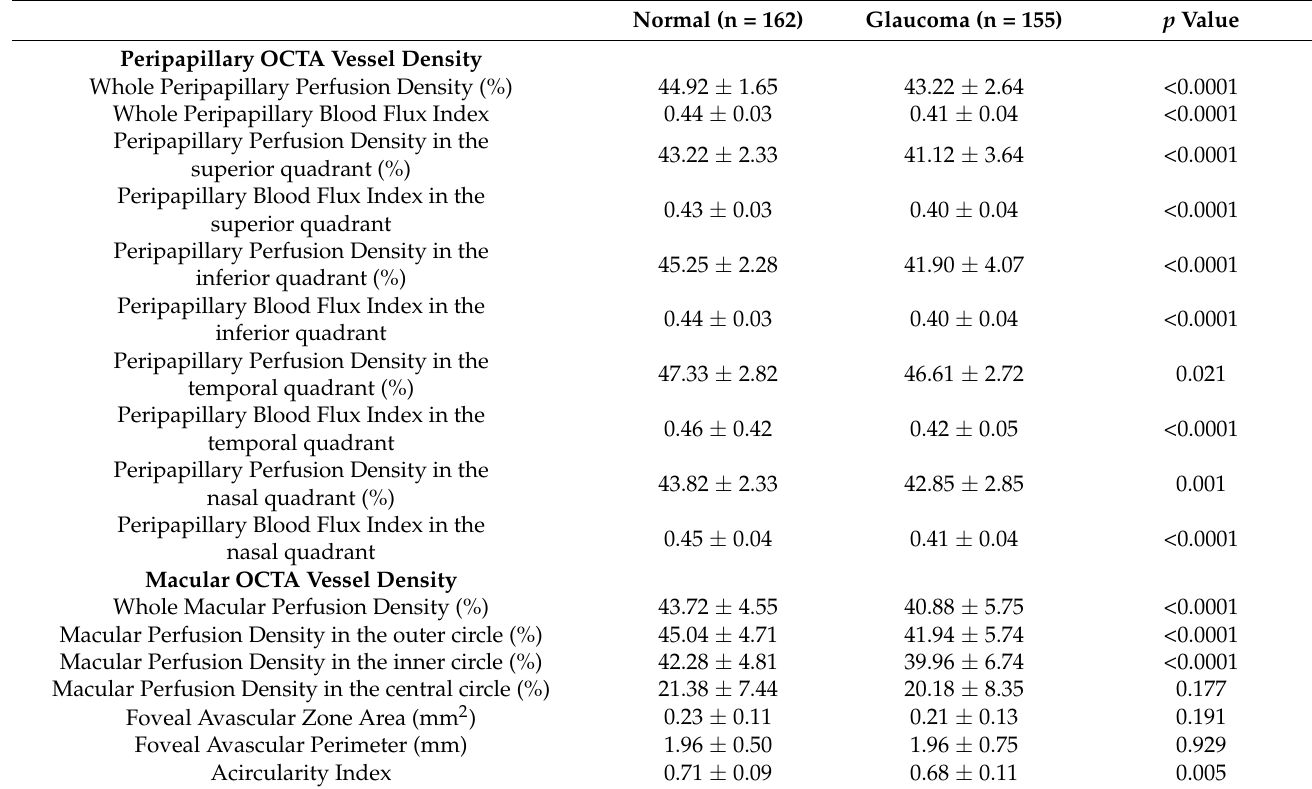
Table 2. Comparison of peripapillary and macular vessel density evaluated by OCTA between glaucoma and normal